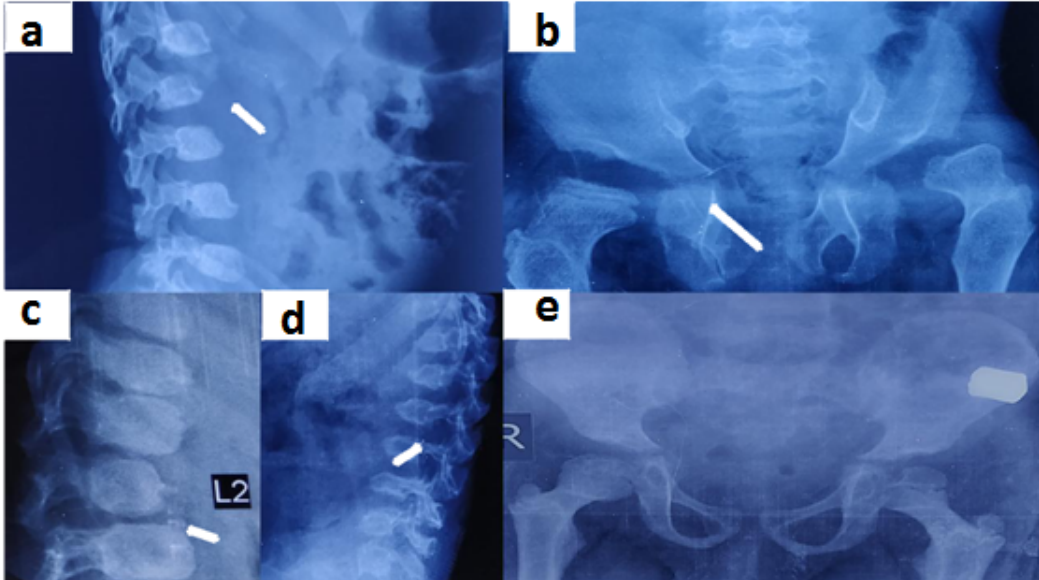
Figure 5. Dysostosis multiplex involving vertebral bod ies, pelvis and hip 5ª Inferior tapering of vertebral body, 5B – Poorly formed acetabulumhip dysplasia, 5C – Anterior hypoplasia of lumbar vertebra, 5D – Central beaking of vertebral body, 5E – Long femoral